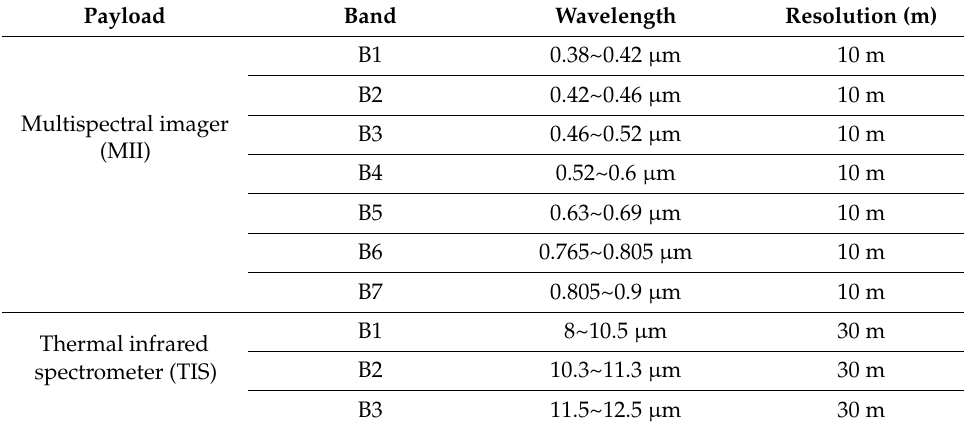
Table 1. SDGSAT-1 TIS/MII main technical